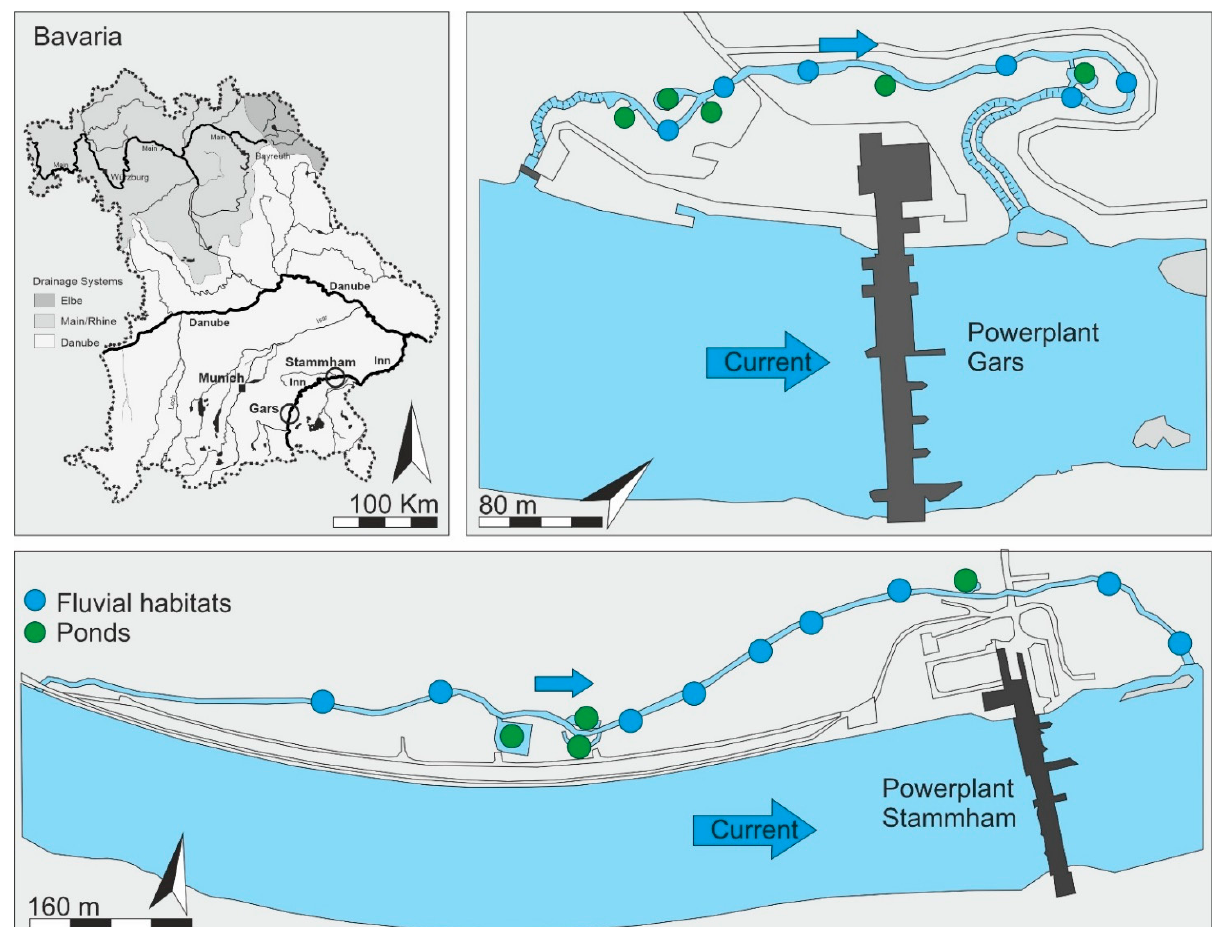
Figure 1. Map of Bavaria with the major rivers and drainage areas. Drainage system of the River Danube into which the River Inn drains is highlighted in light grey, with the location of the two fish passes Gars and Stammham, as well as the sampled fluvial habitats (blue) and ponds (green).